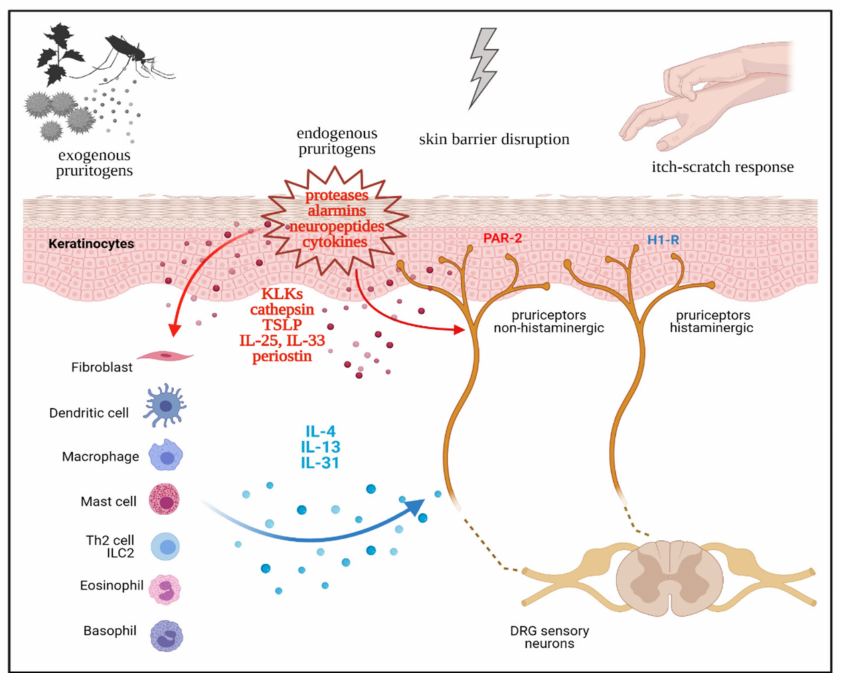
Figure 1. Neuro–immune–epithelial crosstalk between keratinocytes, type-2 immune cells, fibroblasts, and pruriceptors (primary sensory neurons) in the skin, mediating induction and amplification of pruritus. Created with